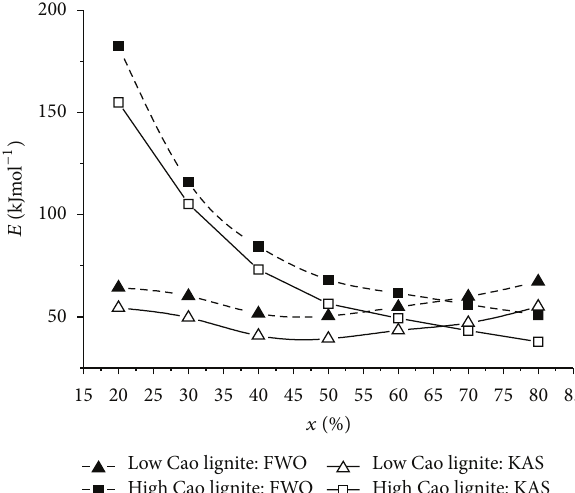
Figure 4: Dependency of apparent activation energy ( 𝐸 ) on conver- sion ( 𝑥 ), determined using the FWO and KAS methods for low and high CaO lignite